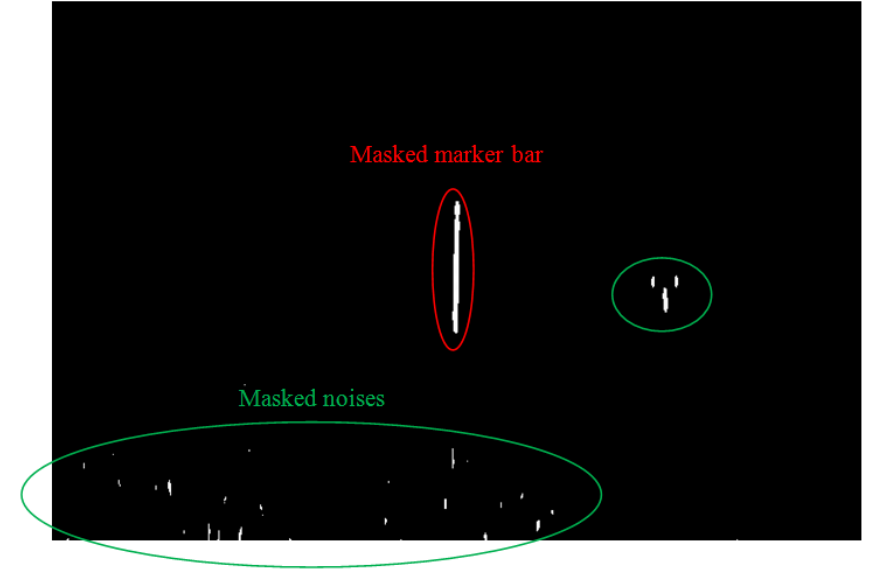
Figure 14. Resultant binary image; masked marker bar (red circle) and masked noises (green